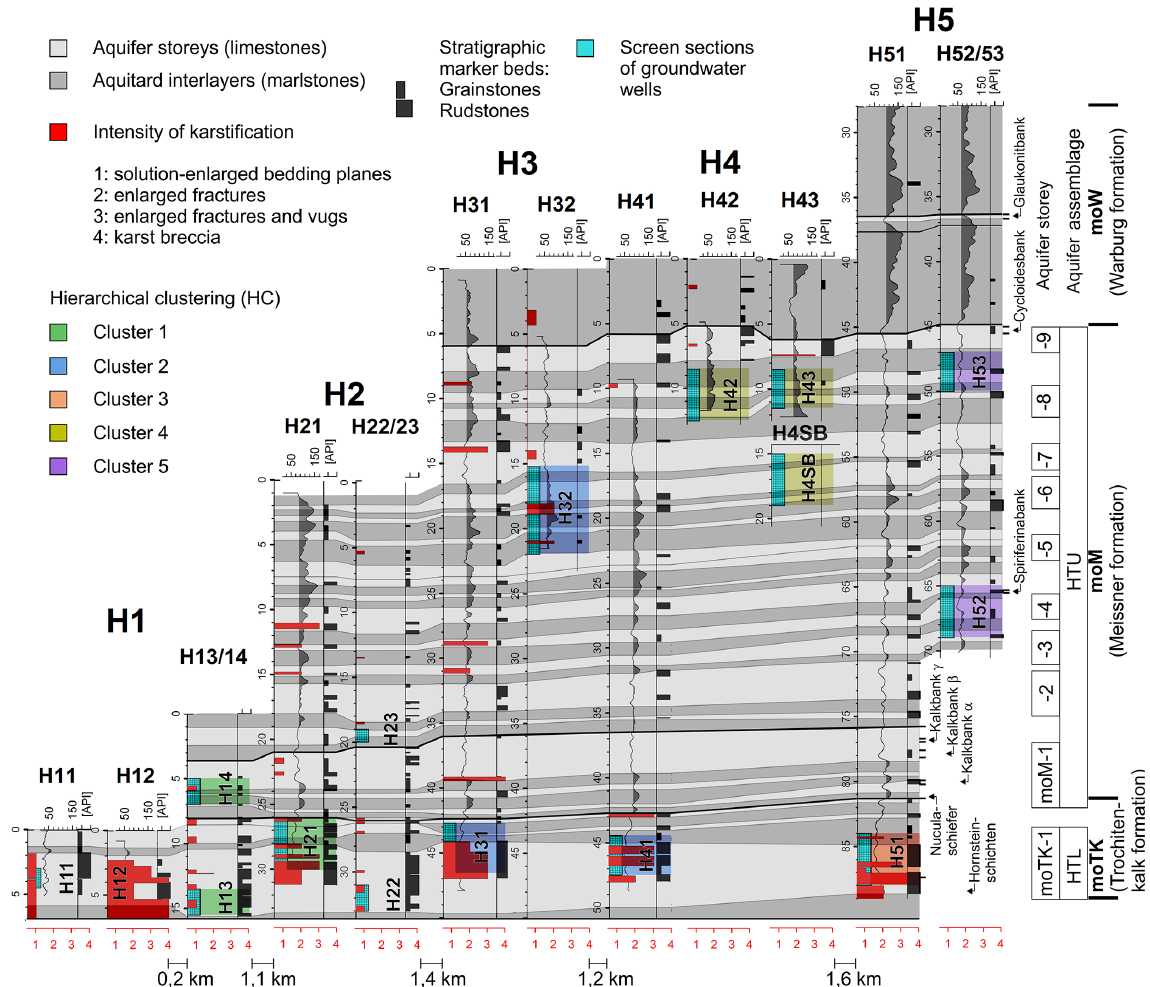
Figure 4. Graphical correlation of marlstone–claystone intervals in gamma-ray logs, biostratigraphic limestone marker beds (grain- stones/rudstones) and the intensity of karstification (red bars and red scale bar below: karstification increases in the direction: solution- enlarged bedding planes to karst breccia). The geological aquifer correlation is cross-checked with the hierarchical clustering of hydrochem- ical